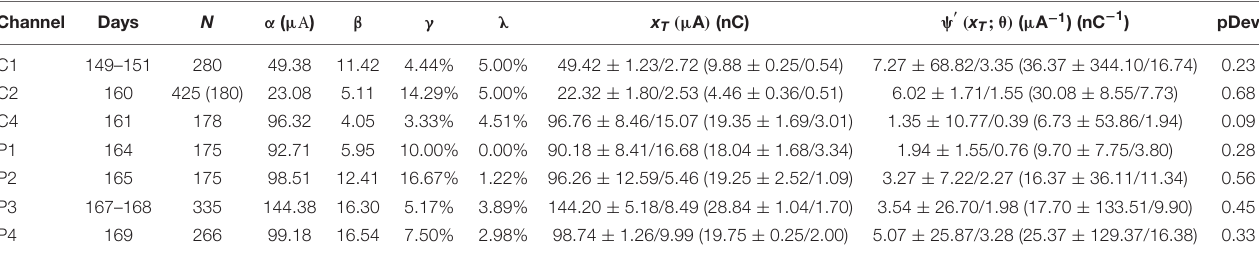
TABLE 3 | Fitted parameters α , β , γ , and λ for psychometric curves generated by single-channel stimulation of channels C1, C2, C4, P1, P2, P3, and P4 in Rat C (see Figure 7 ).